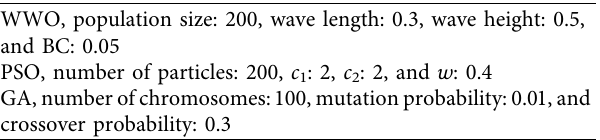
Table 3: The optimal value of the random parameters. WWO, population size: 200, wave length: 0.3, wave height: